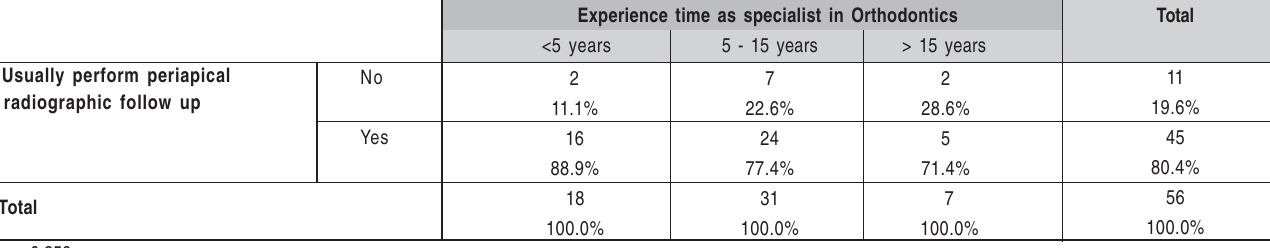
Table 2. Frequency distribution of Orthodontists that usually perform periapical radiographic follow up during orthodontic treatment, stratified by the experience time as a specialist.